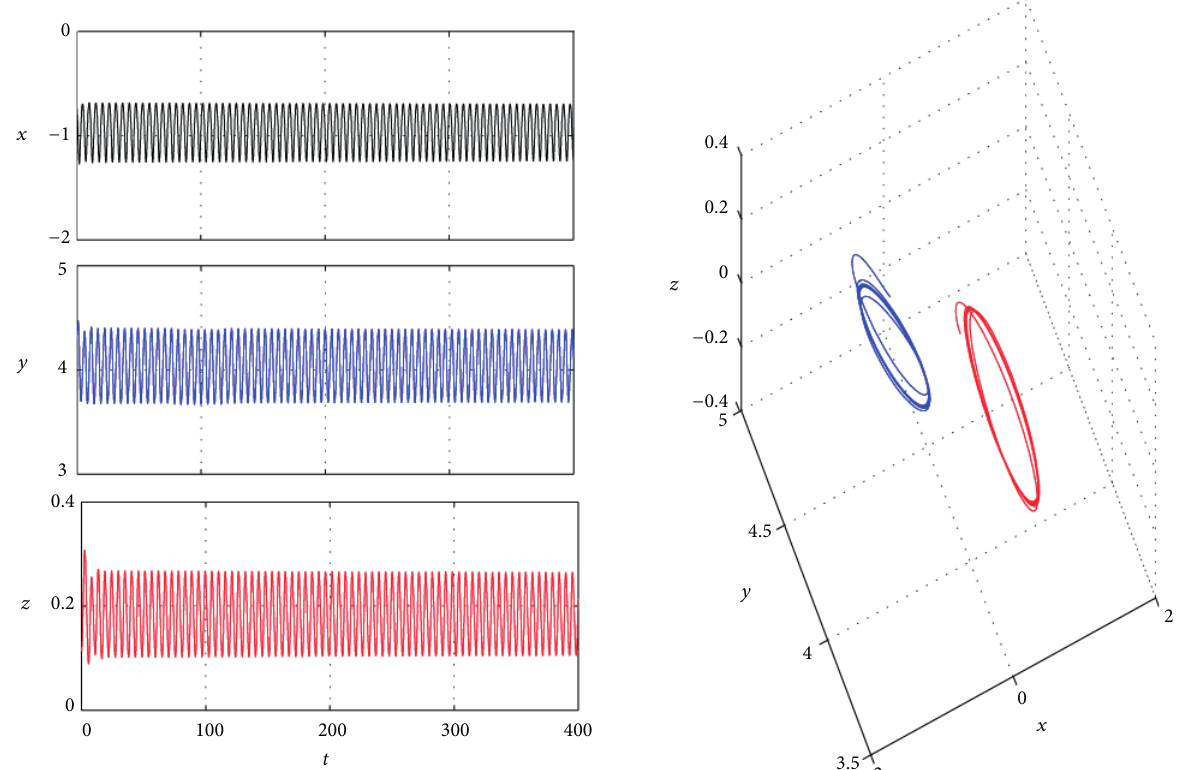
Figure 4: Trajectories 𝑥(𝑡) , 𝑦(𝑡) , and 𝑧(𝑡) and phase graphs of system (4) with 𝑎 = 4 , 𝑏 = 0.1 , 𝑐 = 4 , 𝑘 = 2 , 𝑑 = 1 , and 𝜏 = 2.37